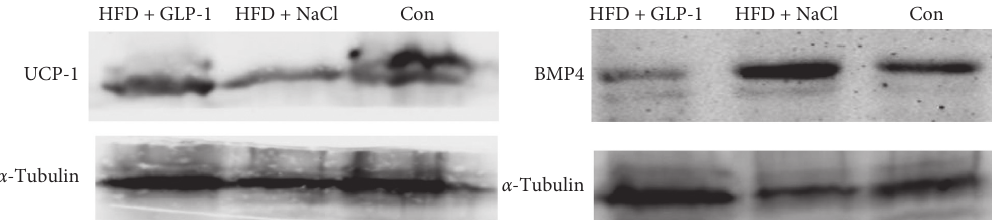
Figure 7: Expression of BMP4 and thermogenic protein in brown adipose tissue. Group A: HFD+GLP-1; Group B: HFD+NaCl; Group C: Con. BMP4: bone morphogenetic protein 4; UCP1: uncoupling protein-1.